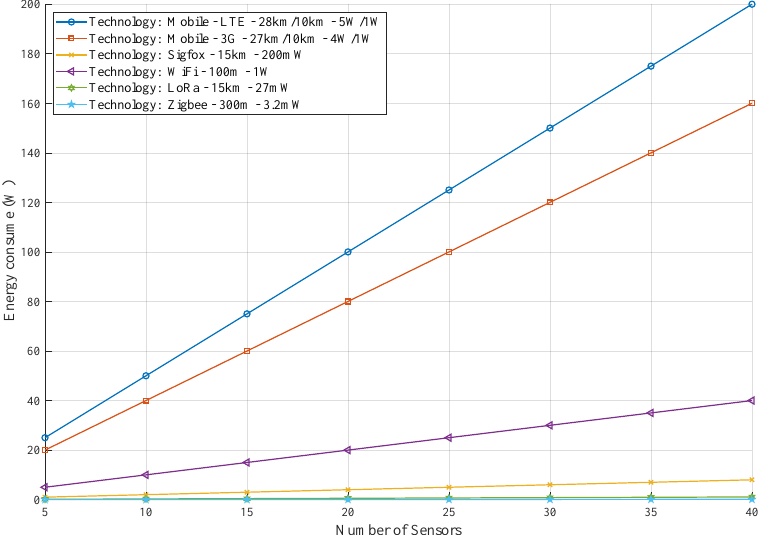
Figure 3. Energy consumption of the wireless